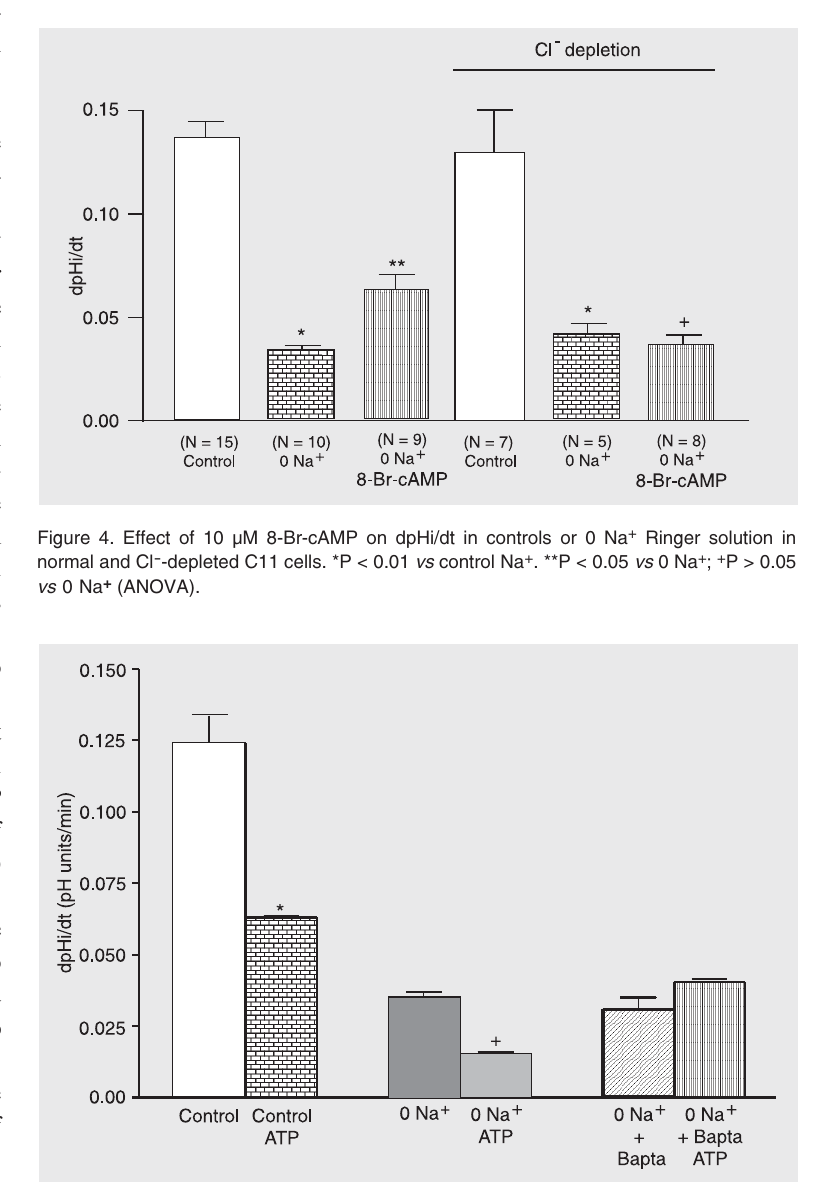
Figure 5. Effect of 100 µM ATP on dpHi/dt in C11 cells superfused with Na + or 0 Na + Ringer solution, and effect of Bapta-AM during superperfusion with 0 Na + solution. *P < 0.01 vs control Na + ; + P < 0.01 vs 0 Na + (unpaired t